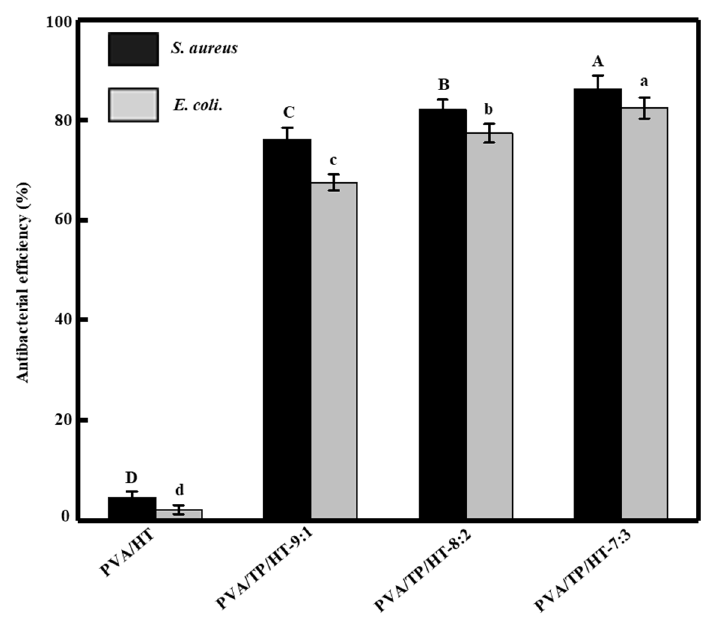
Figure 7. Antibacterial efficiency on E. coli and S. aureus in the nanofiber films. The data followed by different uppercase (lowercase) letters were significantly different ( p < 0.05) when comparing the antibacterial efficiency of nanofibers on S. aureus (E. coli) .